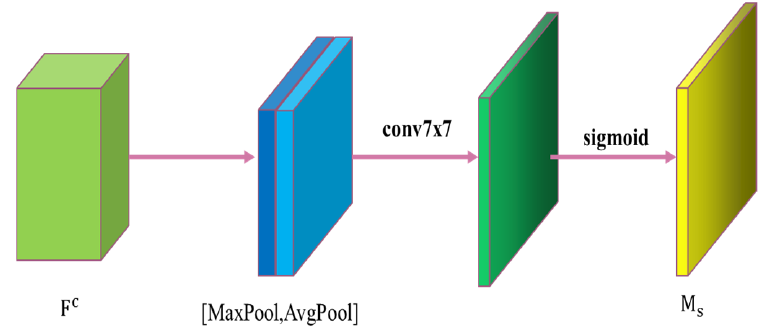
Figure 5. Spatial